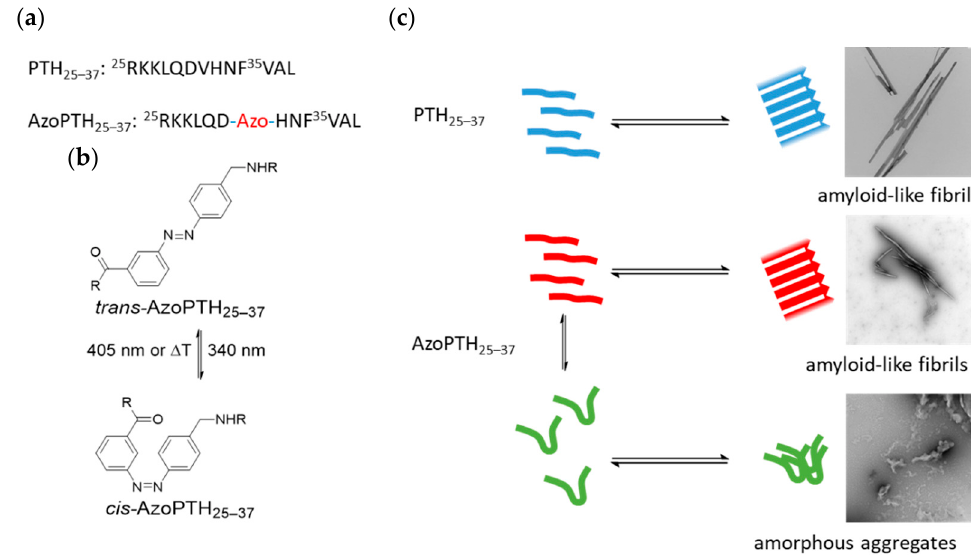
Figure 1. ( a ) Primary sequence of PTH 25–37 and the azobenzene-modified PTH 25–37 (AzoPTH 25–37 , azobenzene-moiety highlighted in red). ( b ) Cis-trans- isomerization of the incorporated 3,4’-AMPB switch. ( c ) Equilibrium of the monomeric peptides PTH 25–37 and AzoPTH 25–37 in both forms and their aggregates.